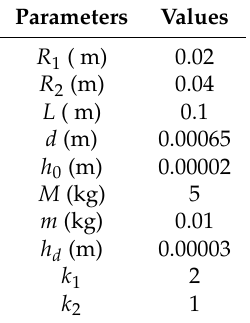
Table 1. Simulation